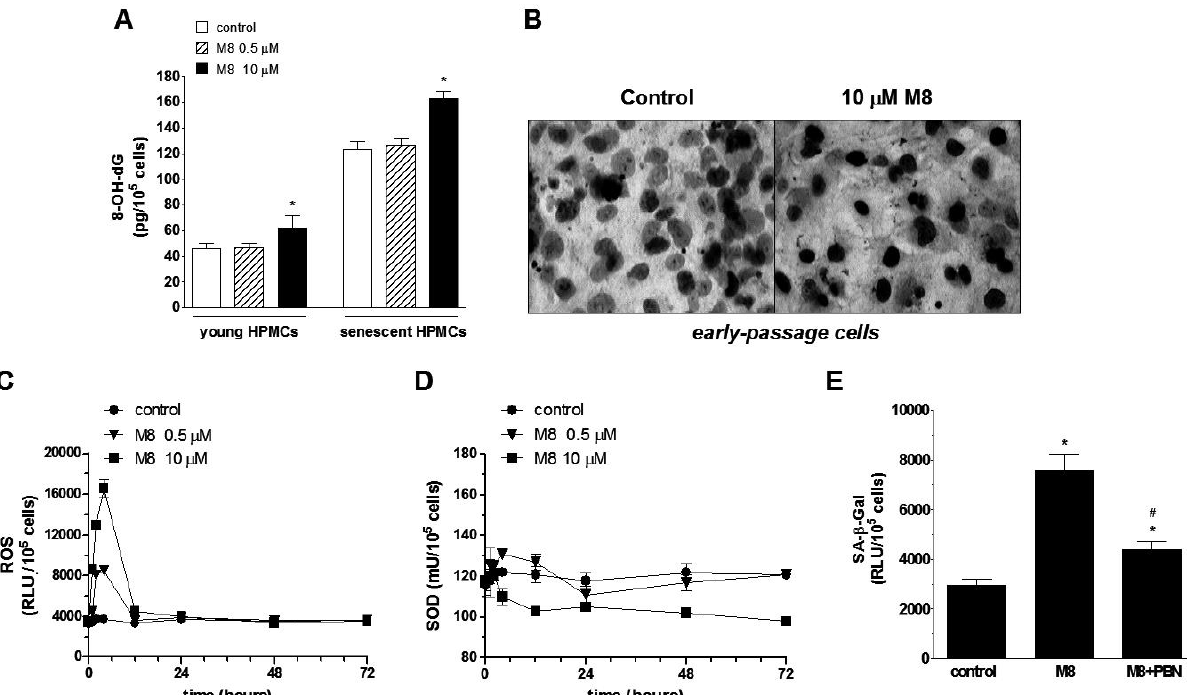
Figure 4. The role of oxidative stress in M8-dependent premature senescence of